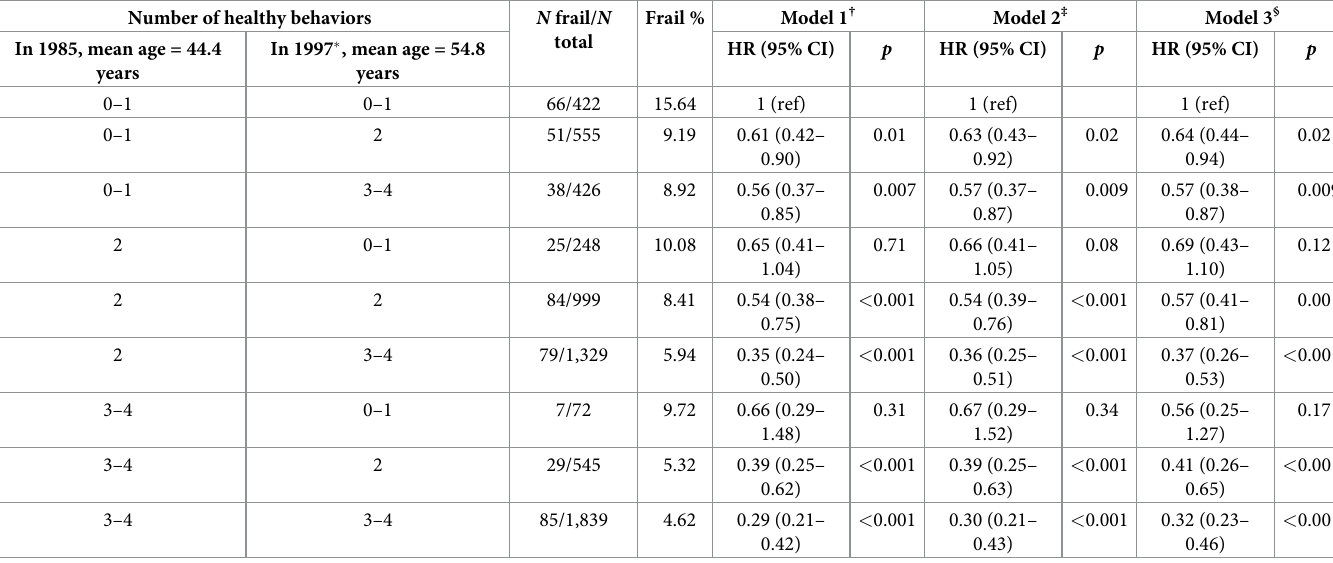
Model 1: age as timescale, adjusted for sex, ethnicity, marital status, and wave of second measurement of health behaviors. ‡ Model 2: model 1 additionally adjusted for education and occupational position. § Model 3: model 2 additionally adjusted for the number of morbidities at the second measurement of health behaviors. Abbreviations: CI, confidence interval; HR, hazard ratio; ref, reference